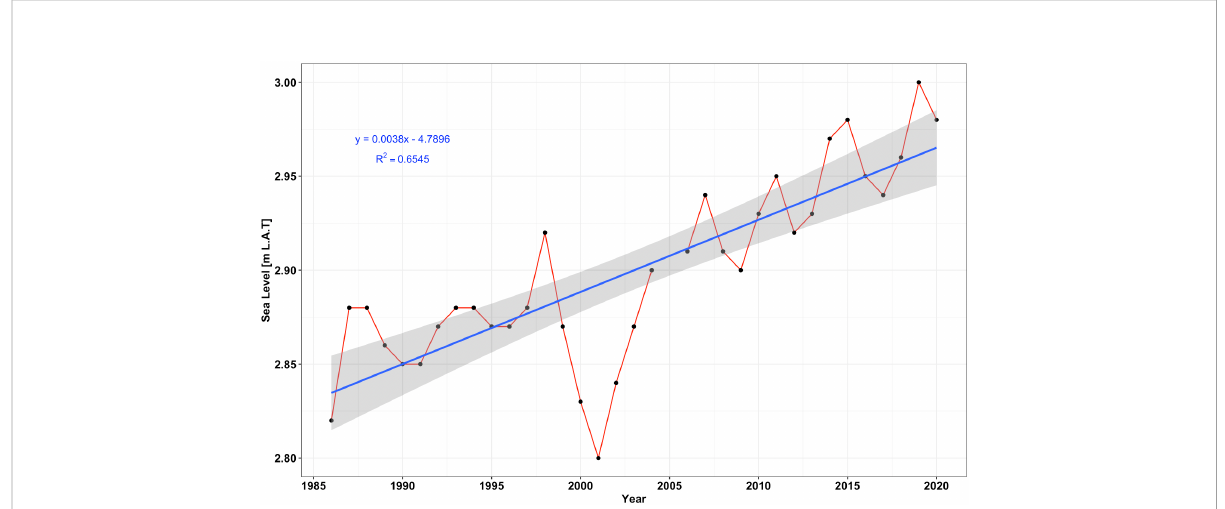
FIGURE 5 Plot showing a rising (increasing) trend of sea-level in Mombasa derived from tide gauge data between June 1986 and December 2020. From the linear trend, the sea level in Mombasa has been rising at 3.8 mm yr -1